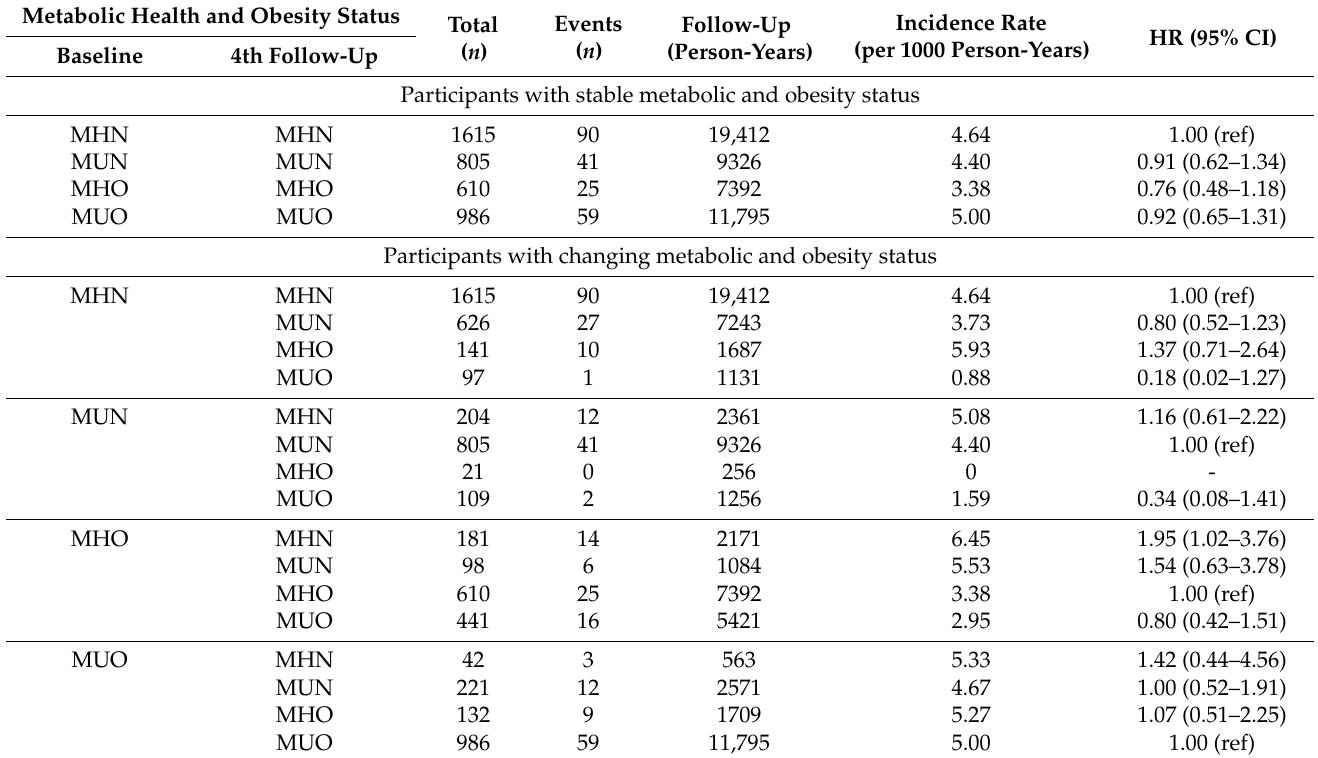
Table 5. Hazard ratios (HRs) and 95% confidence intervals (CIs) for cancer incidence according to the combination of metabolic health risks and obesity status at baseline and fourth